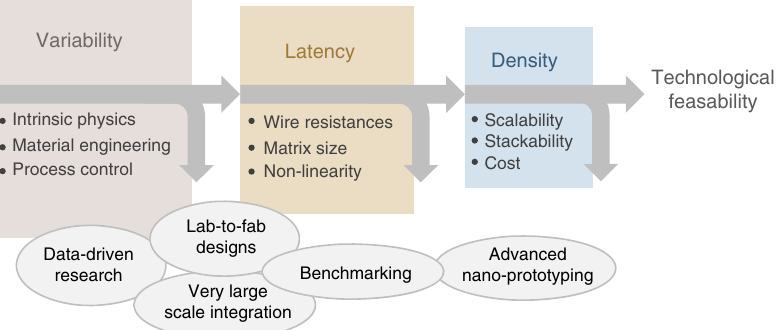
Fig. 2 Roadmap for manufacturing challenges and possible approaches to accelerate progress. Understanding the underlying factors behind variability can be enabled by data-driven research through lab-to-fab designs and very large-scale integration of memristive matrices with traditional digital access circuitry. Benchmarking (performance metrics, standardized device/matrix sizes, methods of testing, etc) will ensure comparable results between groups. Ultimately, once variability and latency issues are tackled, the technology development will bene fi t from advanced nano-prototyping techniques, such as extreme ultraviolet lithography, for cost-effective scalability and